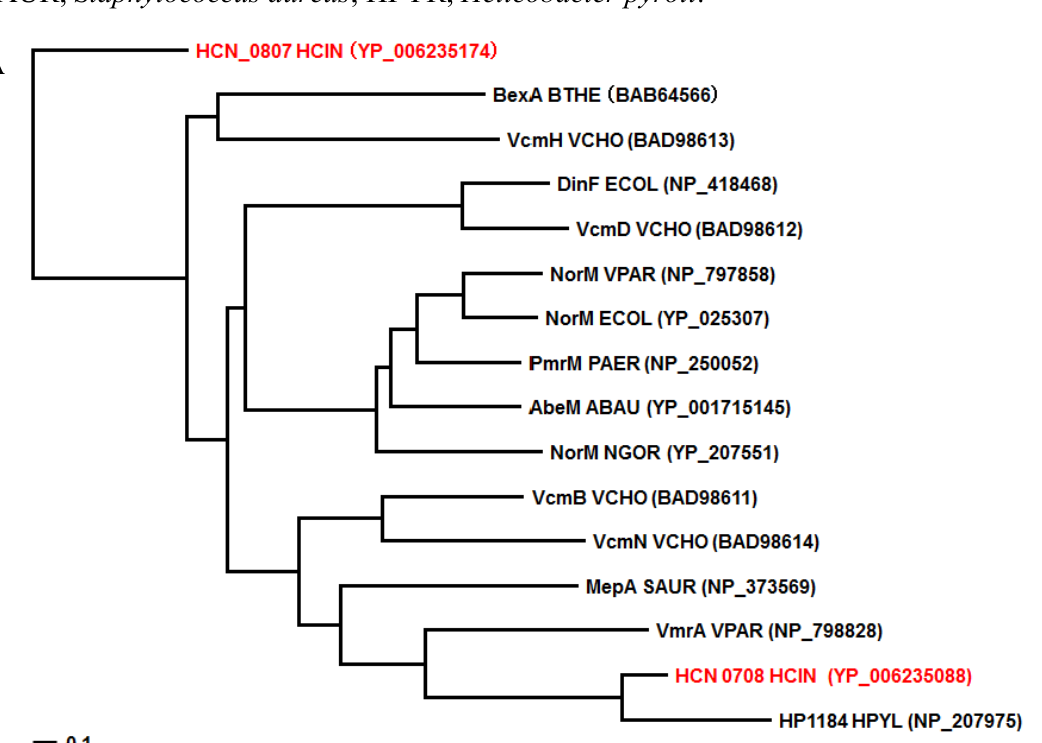
Figure 3. Phylogenetic trees for the MATE pumps of various bacteria. According to the COBALT program, the trees were constructed using the Fast evolution method and rendered with ( A ) Rectangle and ( B ) Radical. The proteins are abbreviated (e.g., “NorM_ECOR” stands for “NorM of E. coli ”). The accession numbers are shown